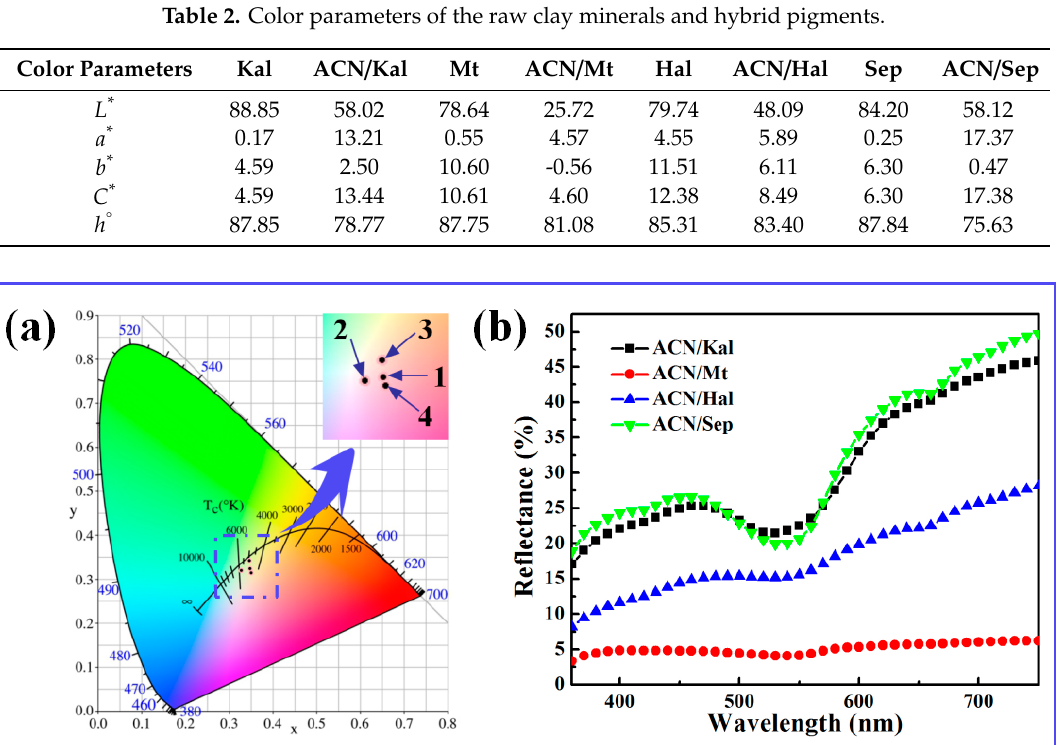
Table 2. Color parameters of the raw clay minerals and hybrid pigments.